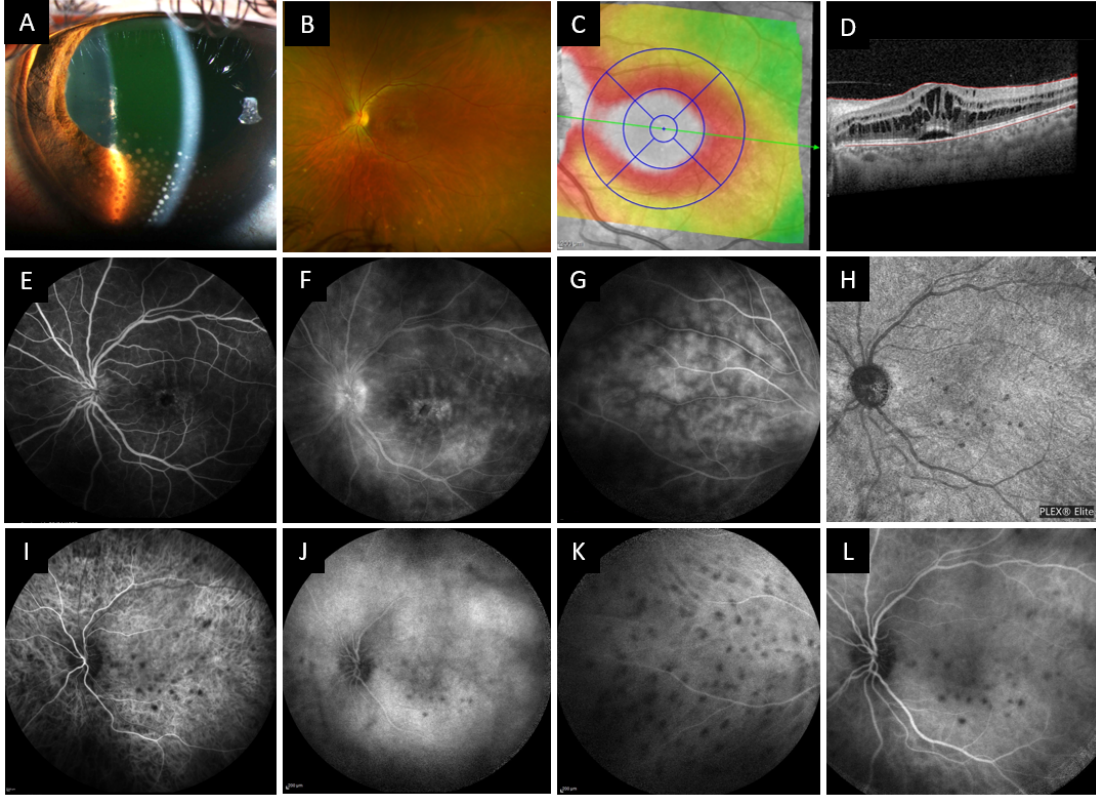
Figure 7. Slit lamp examination, wide field fundus photography, OCT, fluorescein angiography and OCT angiography of case 3 patient. ( A ) Slit lamp examination showing numerous mutton fat keratic precipitates with anterior chamber reaction and posterior synechiae. ( B ) Wide field fundus photography showing macular edema and inferior yellow-white waxy spots. ( C ) OCT Thickness mapping of the macula and B-scan ( D ) showing cystoid macular edema with retro foveolar subretinal detachment. ( E – G ) Fluorescein angiography showing signs of cystoid macular edema, papillitis, capillaritis and choroidal granulomas. ( I – K ) Indocyanine angiography showing hypofluorescent spots most visible in the early phase, present at the posterior pole and periphery. ( H ) OCT angiography of the choriocapillaris at diagnosis showing spots of reduced choriocapillary flow corresponding to choroidal granulomas on the ICG angiogram ( L ).